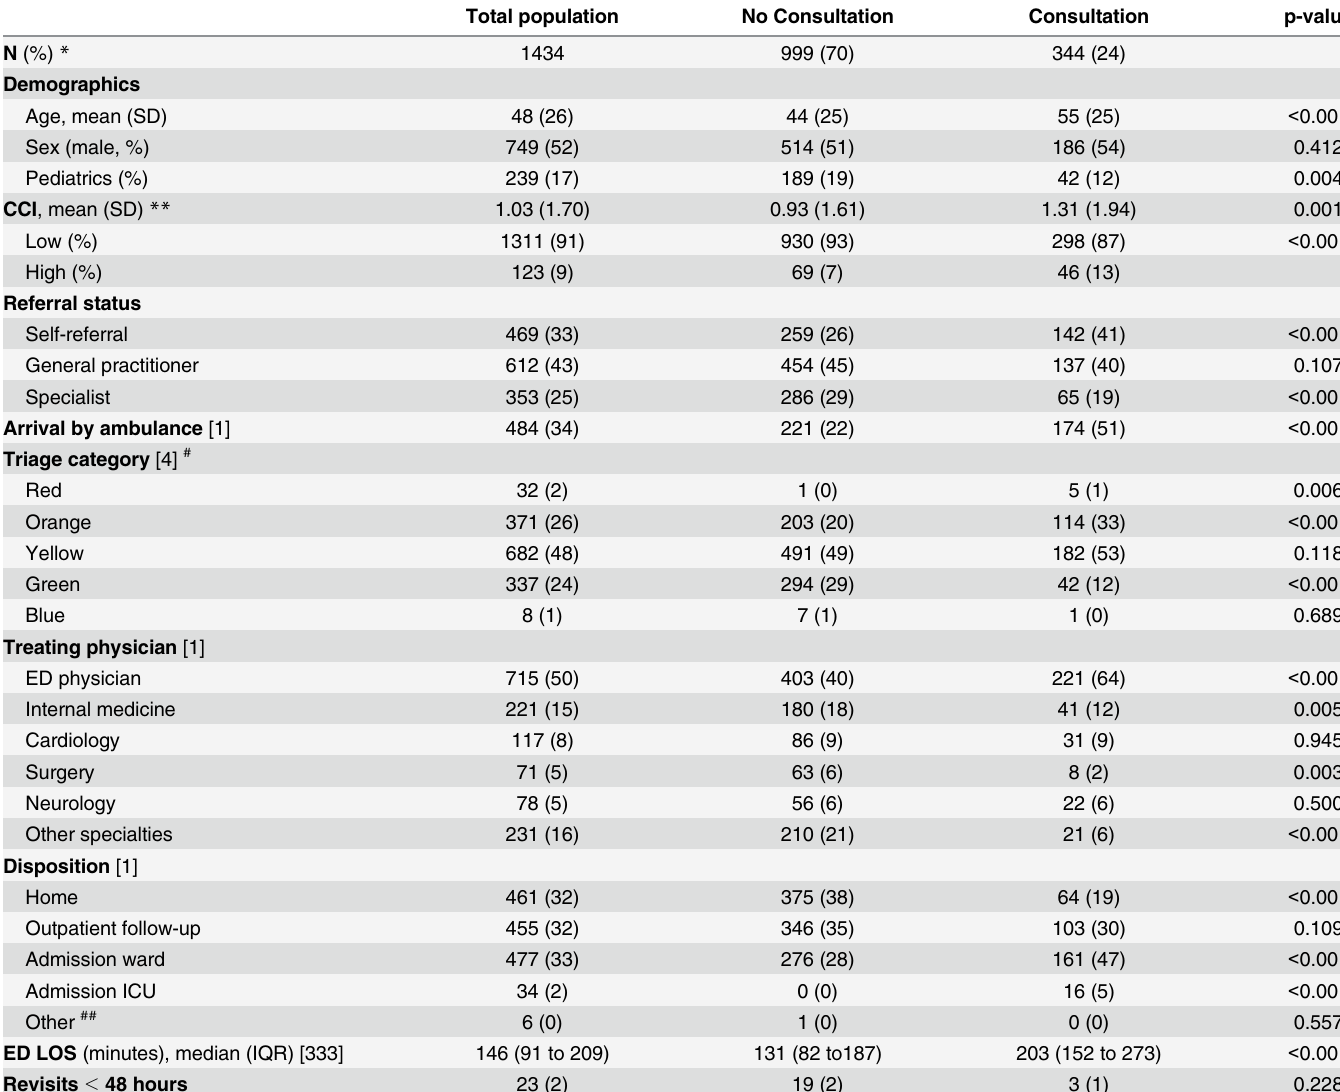
Table 1. Patient